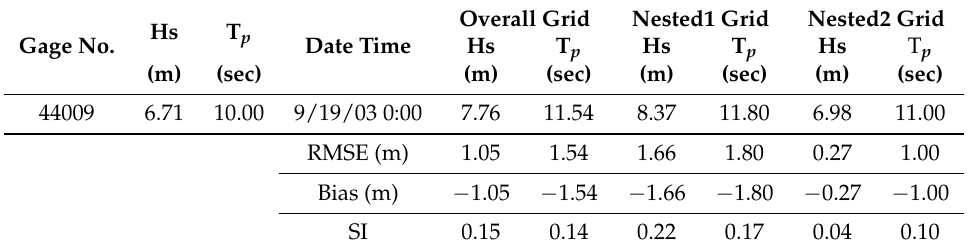
Figure 7. Wind speed (m/s) and direction snapshot from Overall Delft3D model domain at 5:42 a.m. EST ( left ) and 8:42 p.m. EST ( right ) on 18 September 2003. Table 4. Wave calibration results and statistics. Hs is the significant wave height, T p is the peak wave